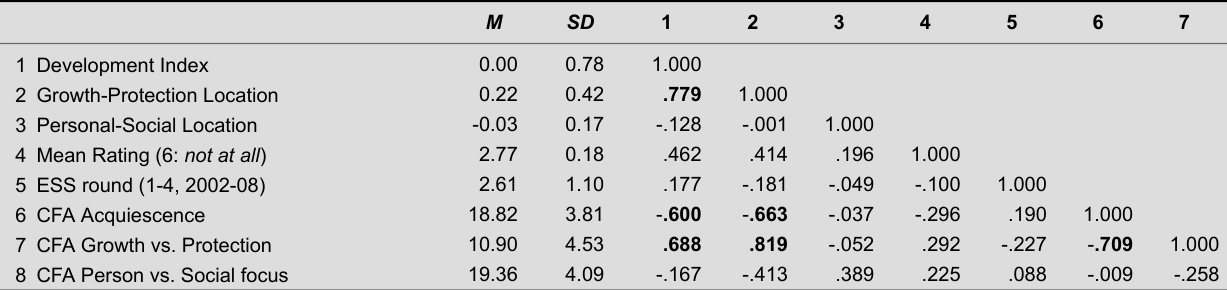
Descriptive Statistics and Correlations (Countries Times Rounds, n = 98